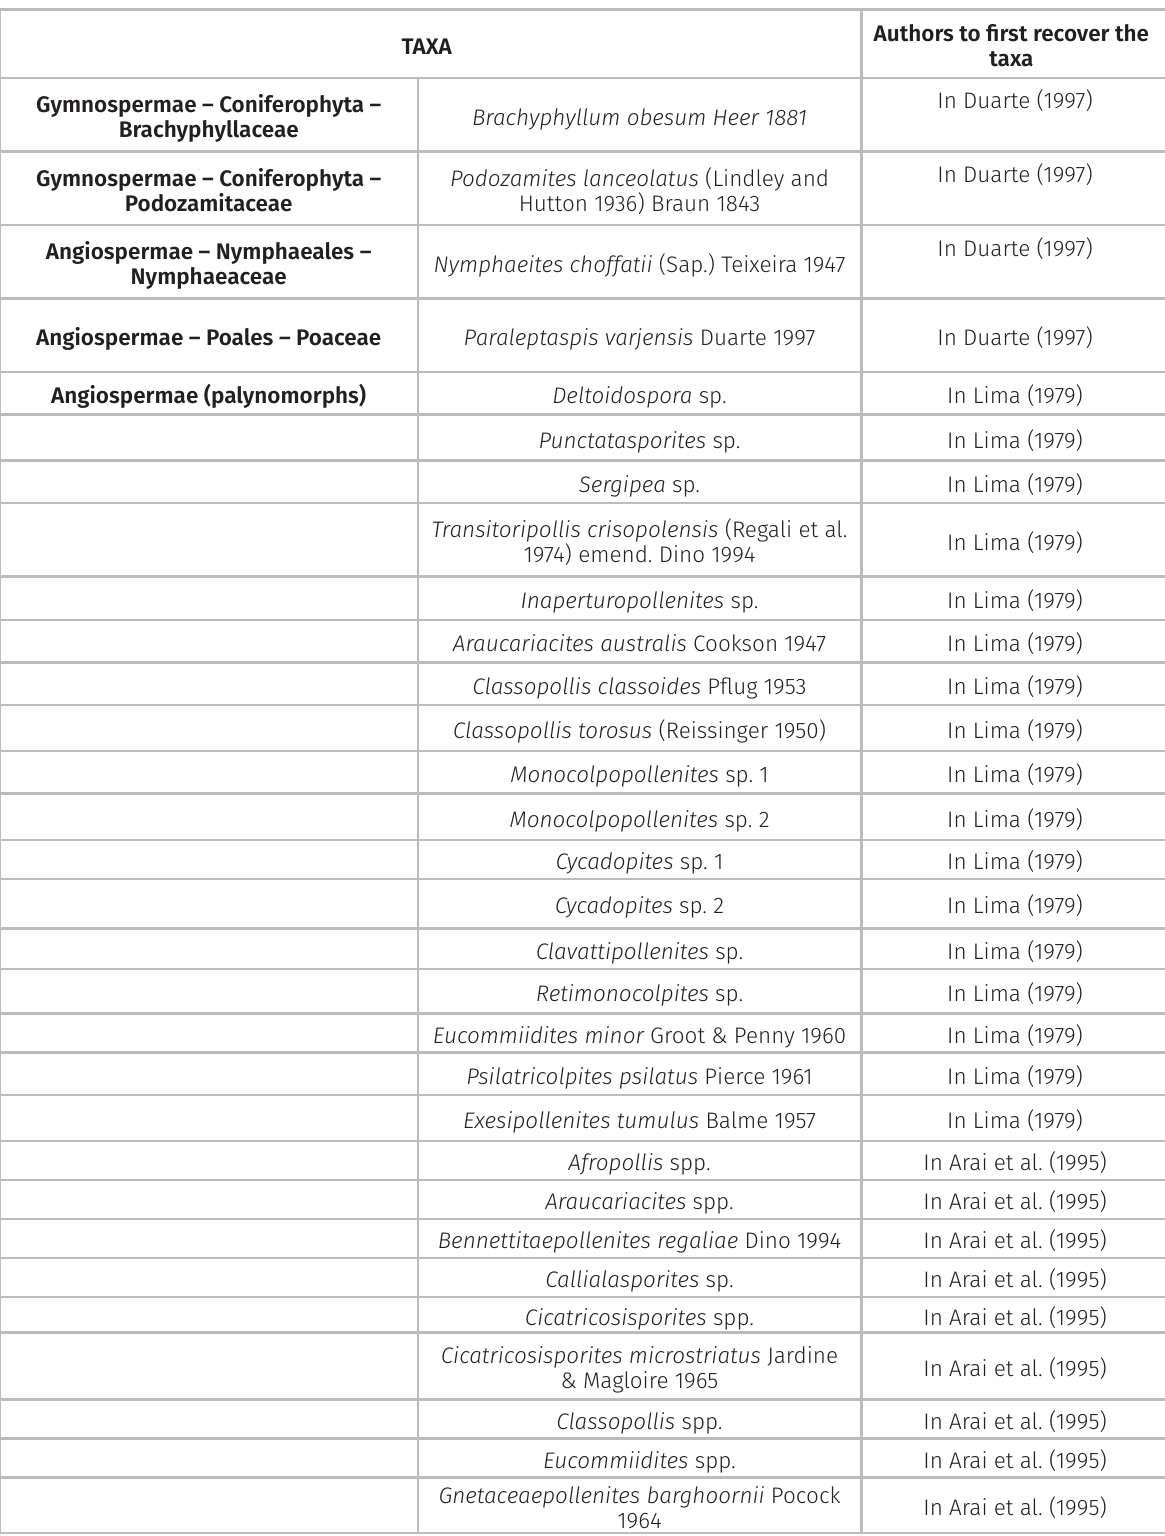
Table I. Fossils from the Quiricó Formation (adapted from Bittencourt et al. 2015).